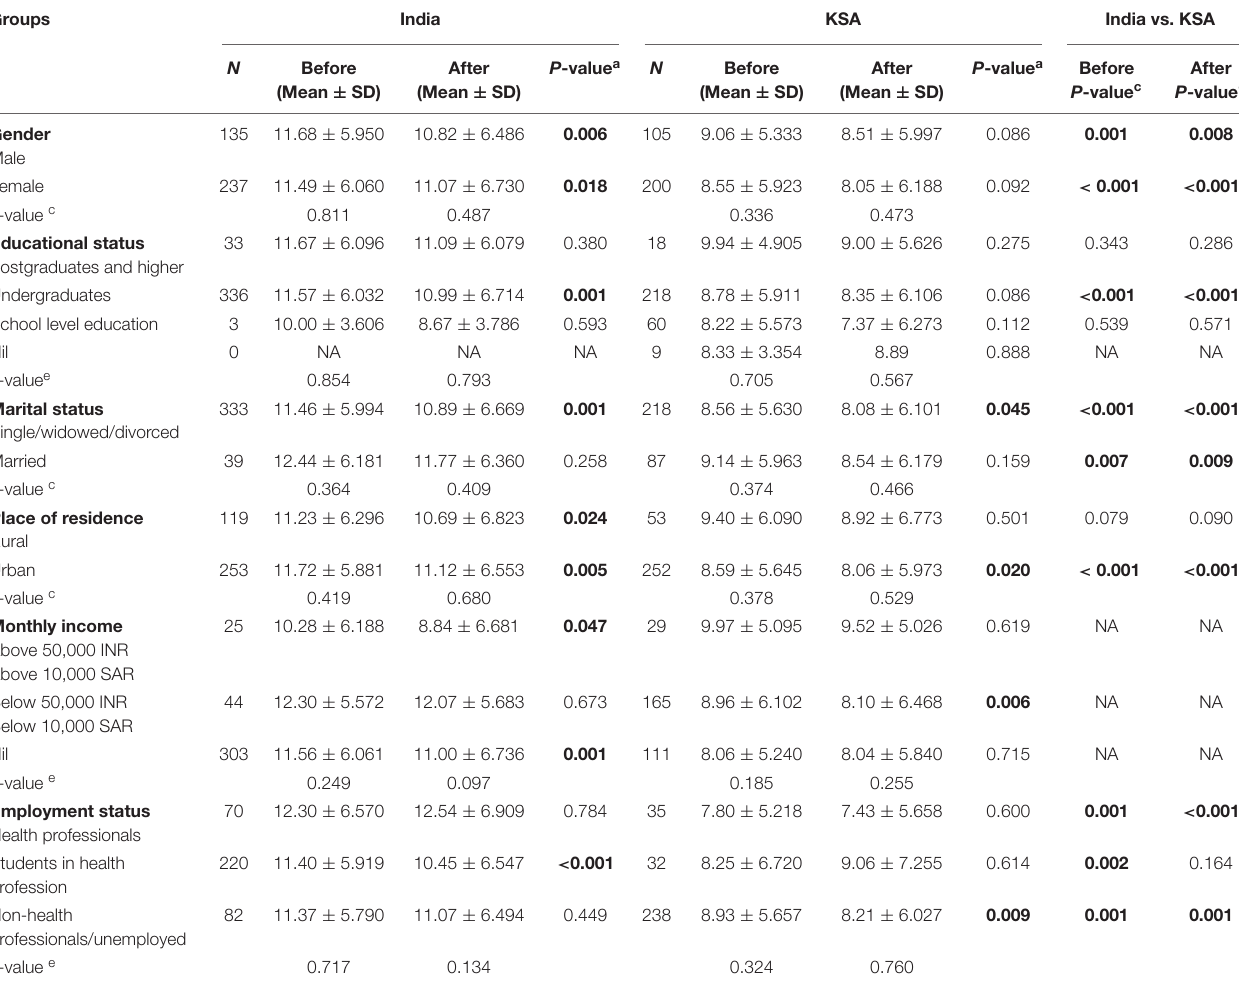
TABLE 4 | Comparison of PTSD symptoms stratified by sociodemographic variables before and after the advent of COVID-19 vaccines.